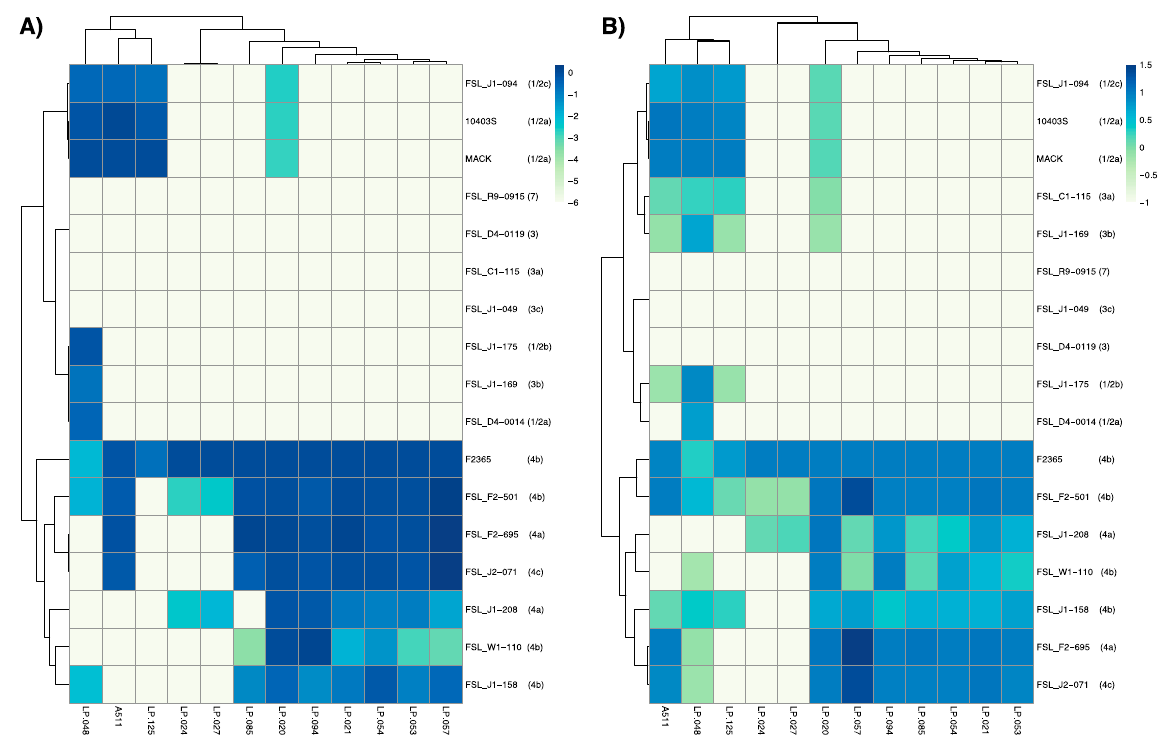
Figure 3. Host range analysis of Listeria phages against a panel of Listeria monocytogenes strains that represent different serotypes. Panel ( A ) represents efficiency of plaquing (EOP) results where values represent the log transformed efficiencies of plaquing of each phage against each bacterial strain compared to the phage propagation host strain. Panel ( B ) represents efficiency of activity (EOA) results where values represent the greatest dilution factor where phage activity was observed against each strain relative to the phage propagation host strain. Values are the mean of data from three biological replicates.